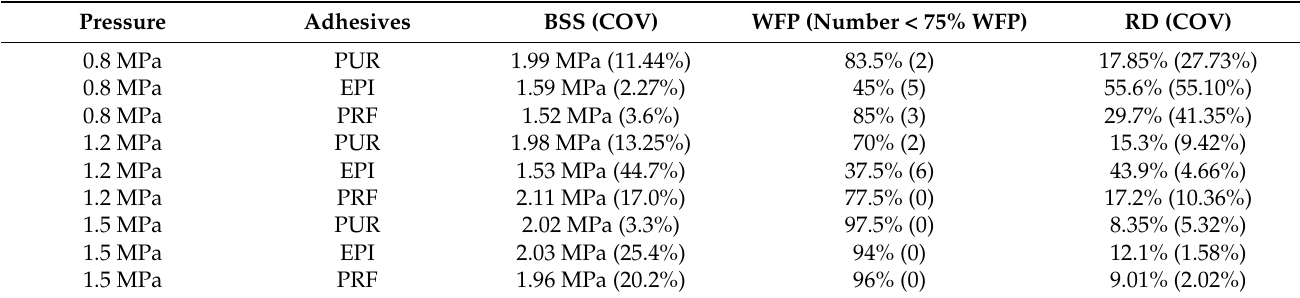
Table 3. Effects of adhesives and bonding pressures on wood failure percentage (WFP), block shear strength (BSS), and rate of delamination (RD) (COV means coefficient of